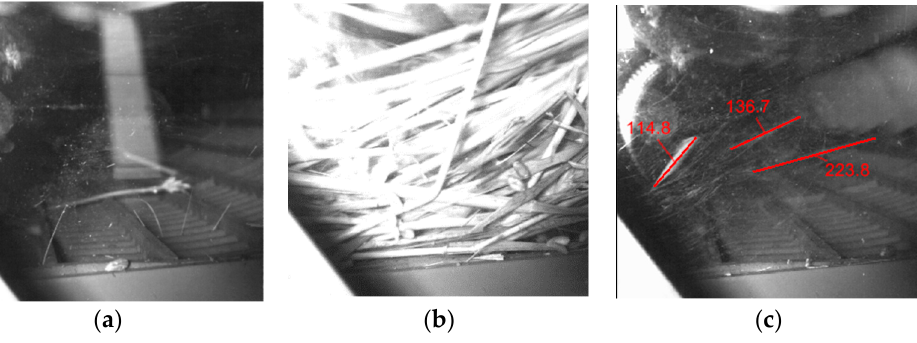
Figure 5. Conveying time collection. ( a ) Image at the beginning of the experiment; ( b ) Image during the stalk conveying; ( c ) Image at the end of the stalk conveying.